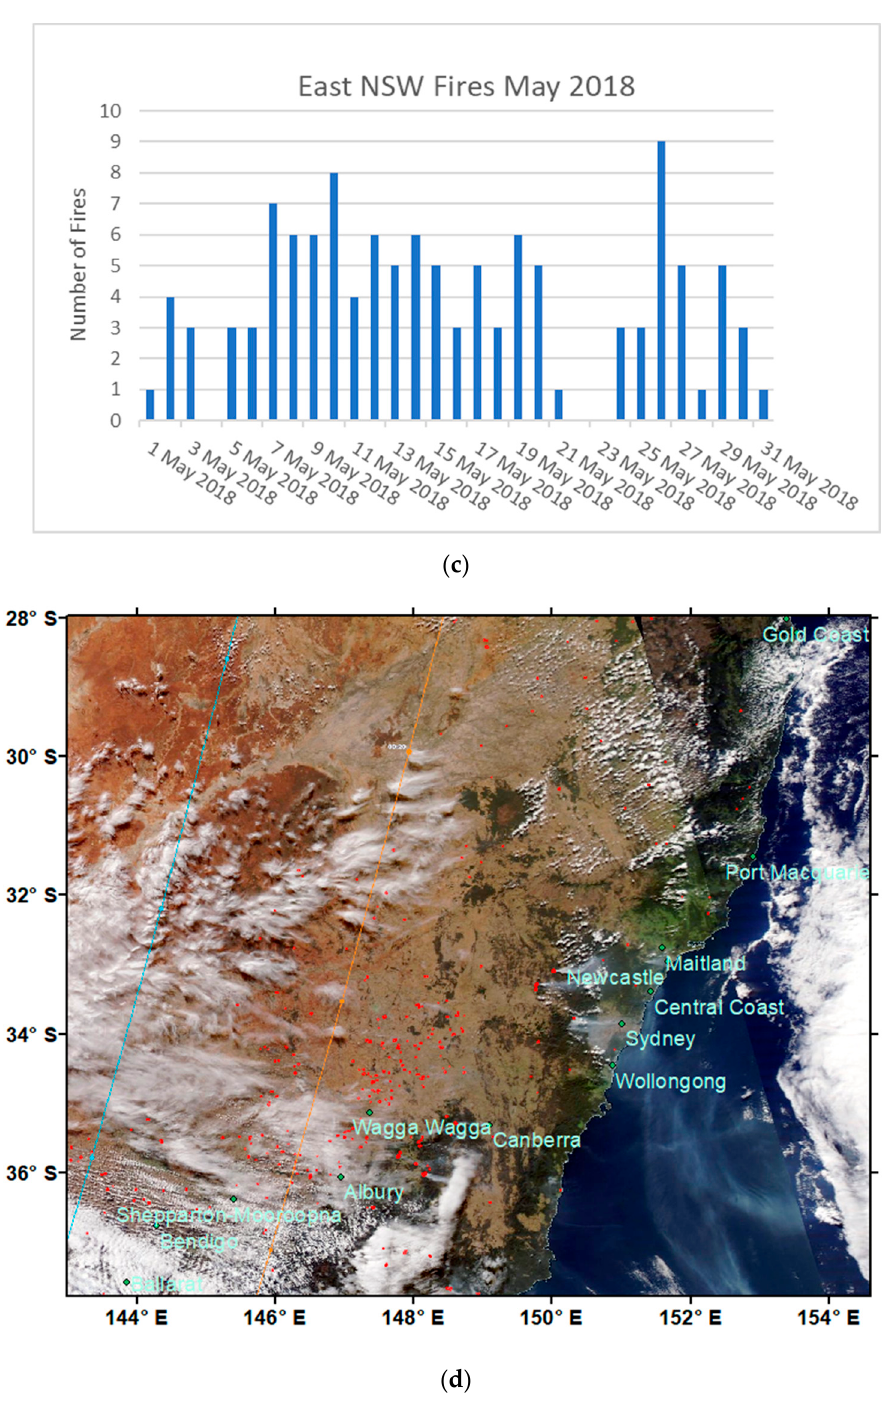
Figure 19. ( a ) Daily average PM 2.5 concentration at Chullora for May 2018 period; ( b ) the regression of BC and PM 2.5 as measured at Chullora showing a linear relationship with correlation coefficient R 2 = 0.696; ( c ) the daily number of hazardous reduction burnings in the region around Sydney; and ( d ) MODIS Aqua/Terra satellite image with hot spots and burn area location on 9 May 2018. Note that smoke plumes from the fires in the Blue Mountain and in the western region affects the nearby Sydney metropolitan areas including the Central Coast and Newcastle. Many hot spots mainly due to agricultural burnings are also visible in the Riverina (middle of map ( d )).